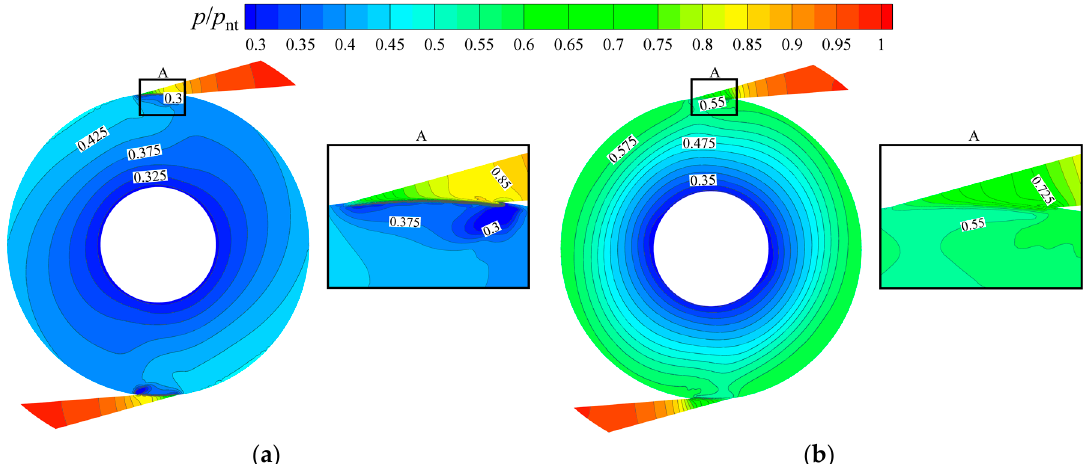
Figure 16. Contours of pressure ratio on the mid-sections of DC1 for one-to-many Tesla turbine cases with different disc spacing distance at 30,000 r/min: ( a ) Case 1-0.3; and ( b ) Case 1-1.